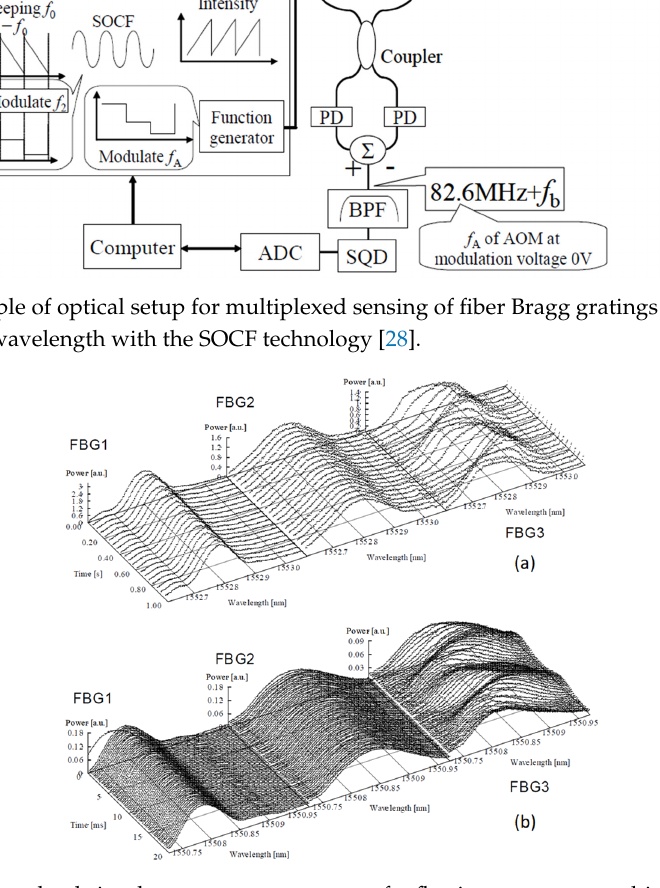
Figure 11. Time-resolved simultaneous measurement of reflection spectra at multiple FBGs with the random accessibility by the setup shown in Figure 10 [28]. ( a ) Random access measurement of the reflection spectra at the three FBGs, which are located along the fiber as shown in Figure 10, with a total measurement speed of 60 Hz. ( b ) Random access measurement of the reflection spectra at three FBGs, which are located along a fiber portion of a 10 m length, with a total measurement speed of 10 kHz.